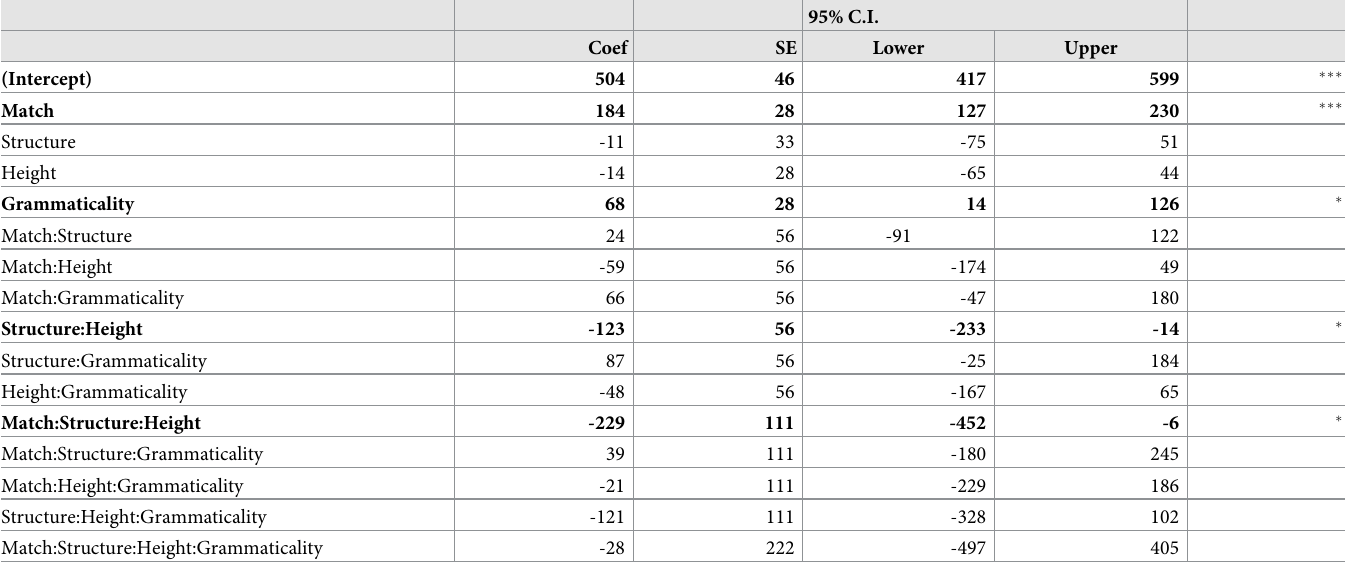
Table 4. Mixed-effects linear regression on judgment times in Experiment